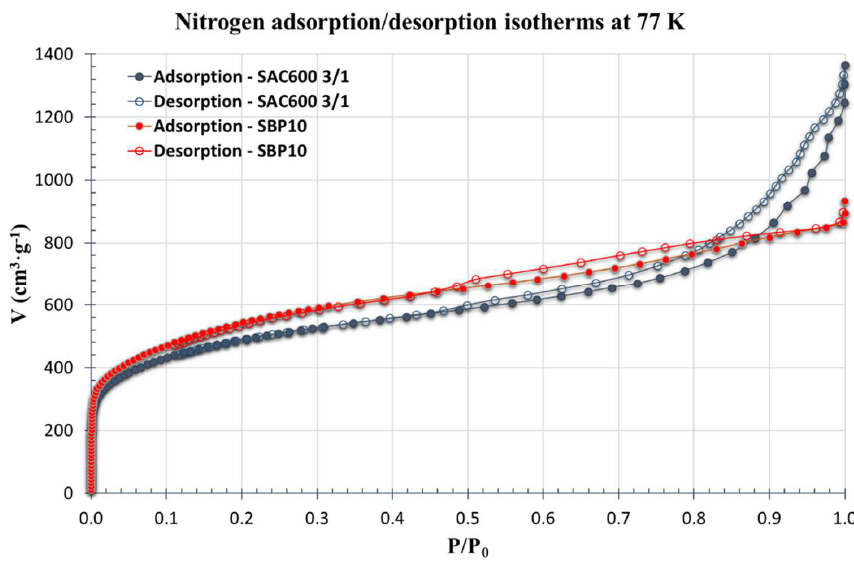
Figure 2. Nitrogen adsorption/desorption isotherms at 77 K on SAC600 3/1 and SBP10.